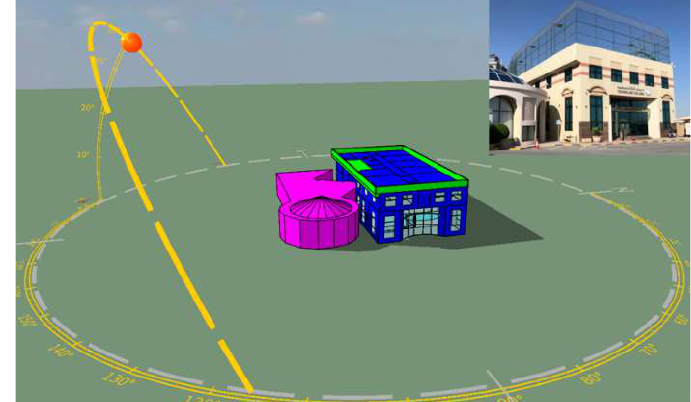
Figure 3. Building Technology’s IES-VE model. Table 1. Simulation inputs for the building’s properties.